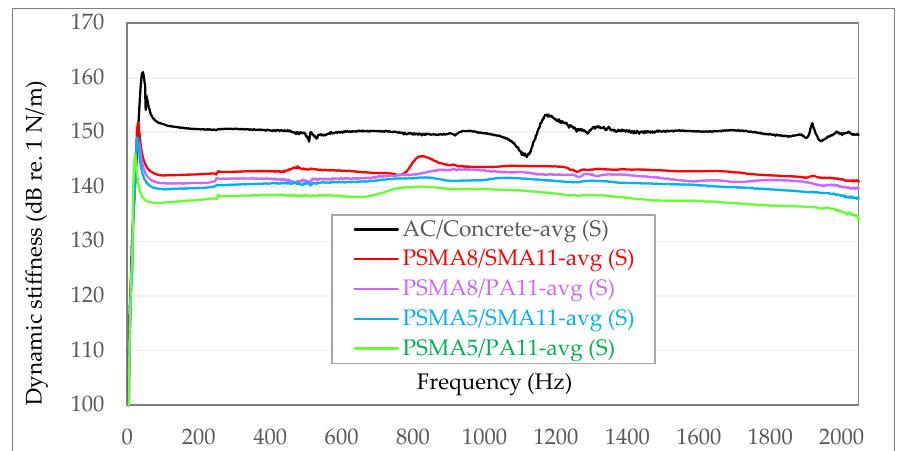
Figure 11. Summary of averaged values of dynamic stiffness from individual measurement series for in situ measurements (S).